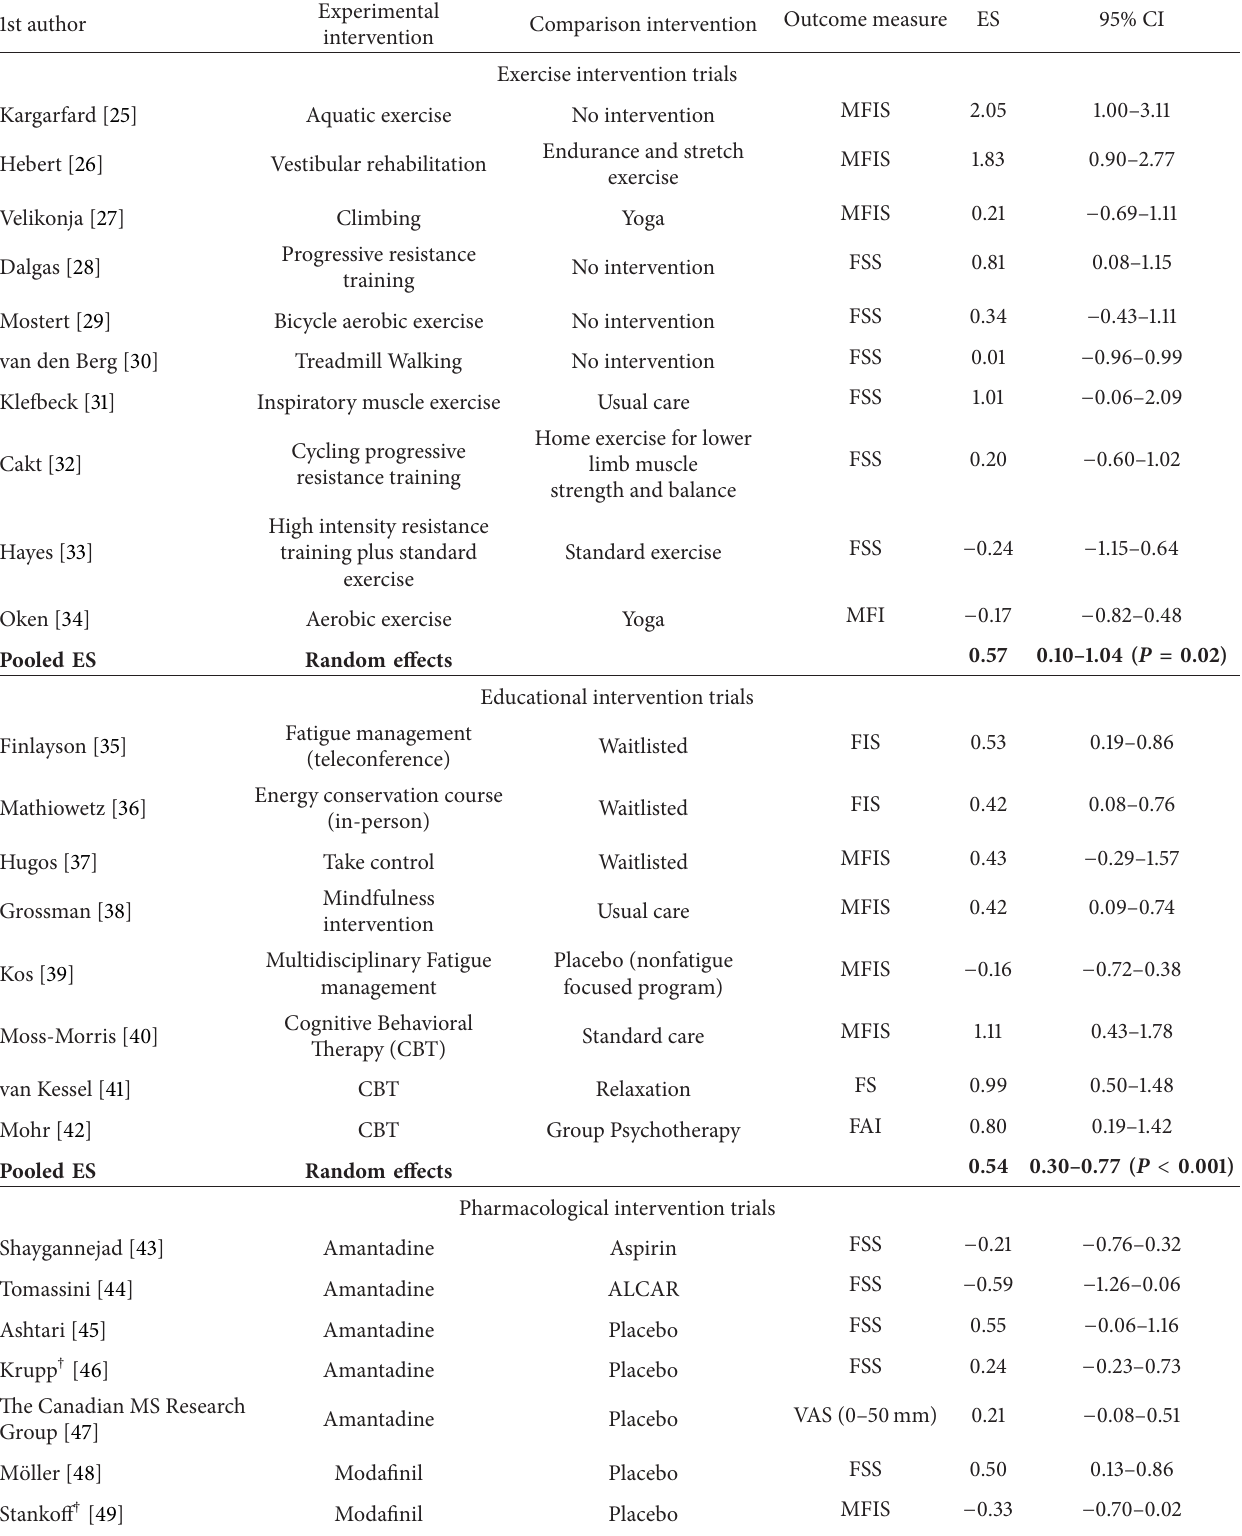
Table 2: Corresponding table for forest